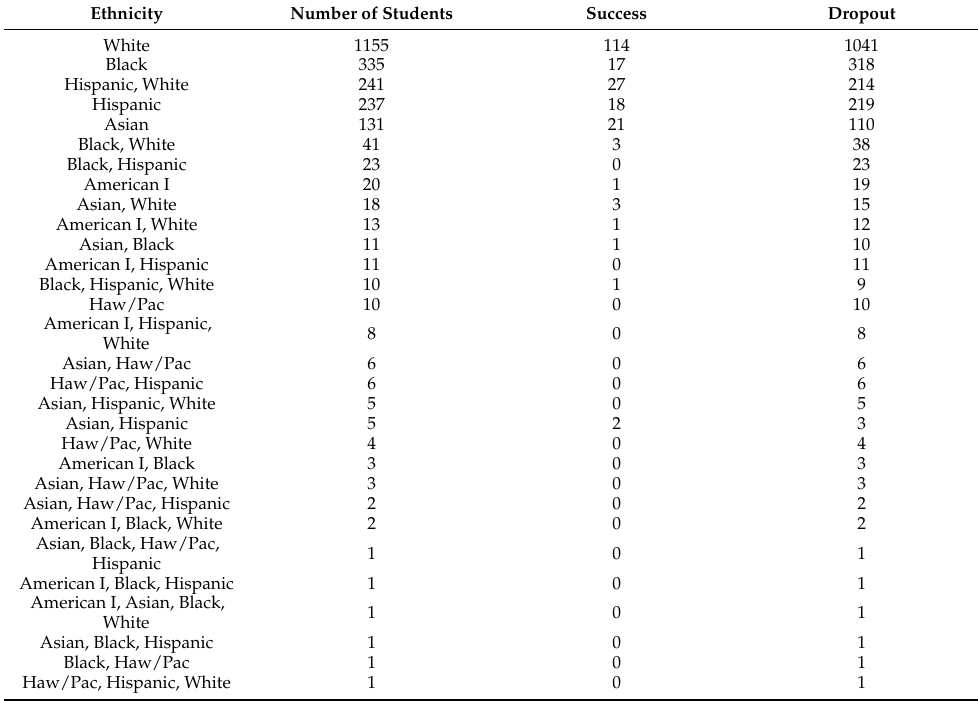
Table A3. Distribution of Students Across Different Ethnic